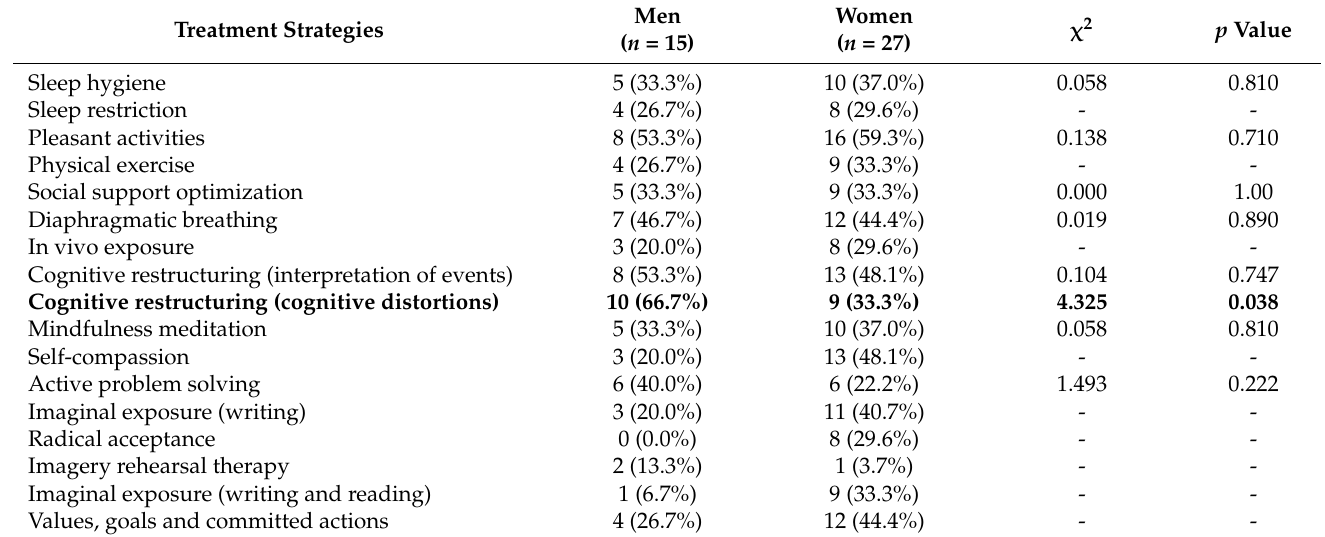
Table 6. Subjective appreciation of treatment strategies by gender: perception of having put strong